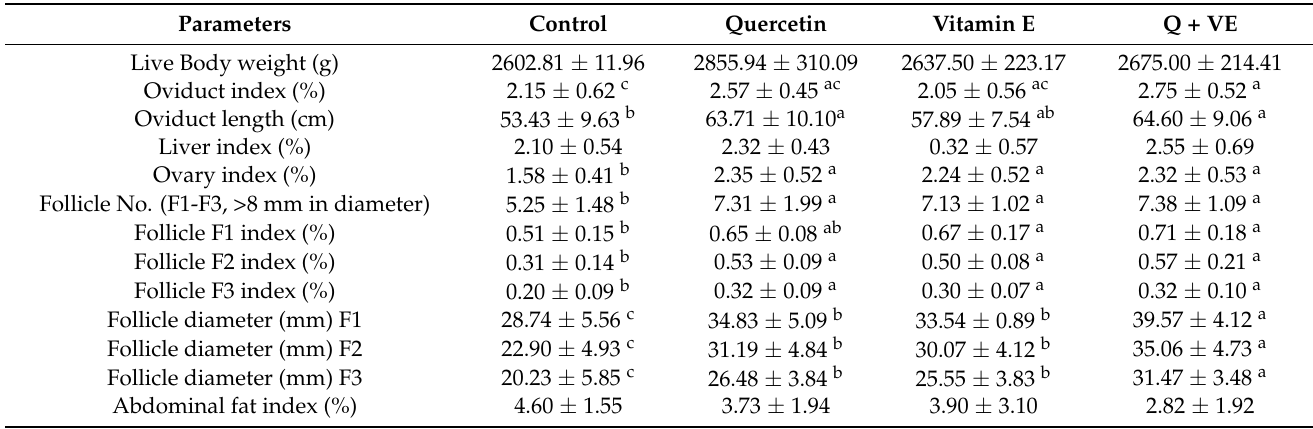
Table 3. Effects of dietary quercetin (Q), vitamin E (VE), and their combination (Q + VE) on the reproductive organ characteristics of aging breeder